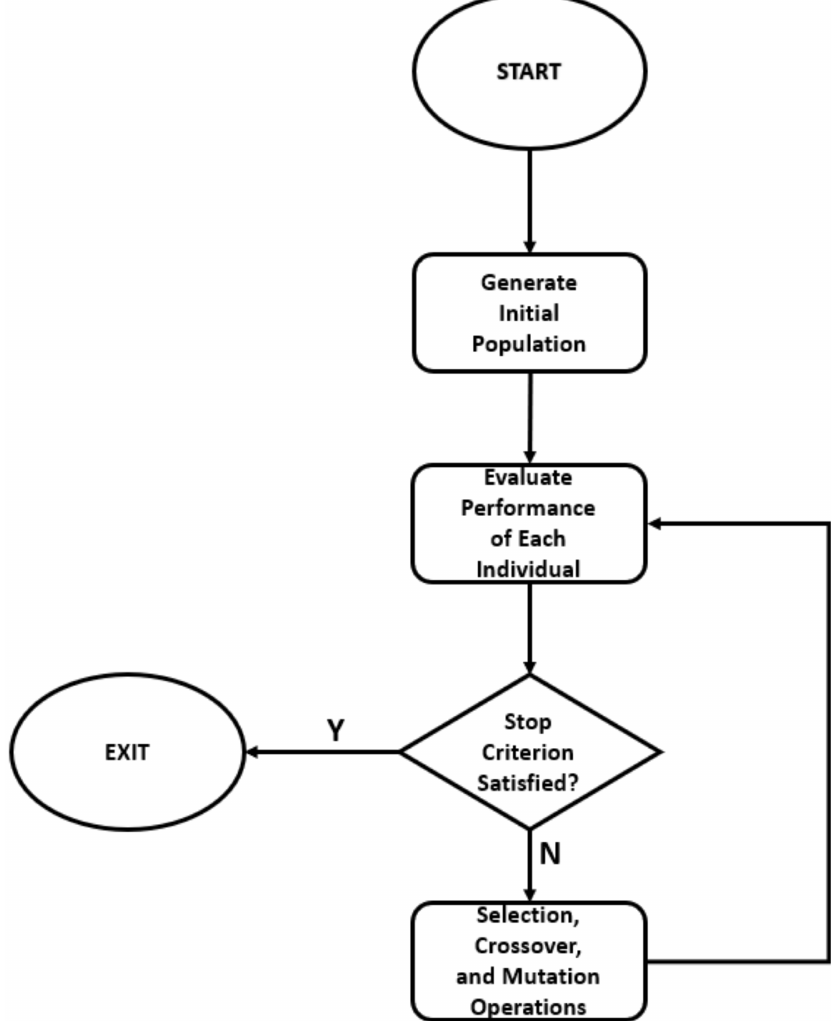
Figure 8. Genetic algorithm flow